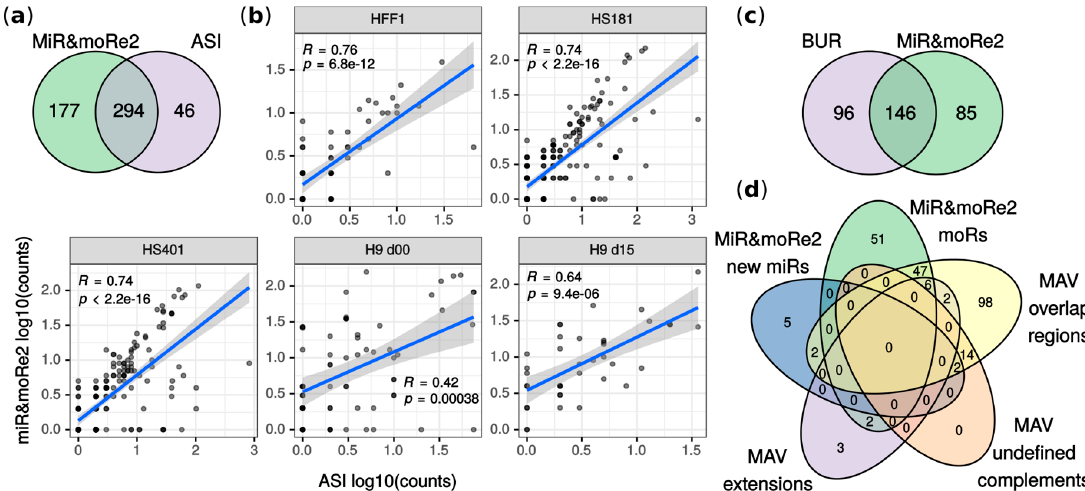
Figure 2. Comparison between original work results and miR&moRe predictions. ( a ) MoRNAs detected by miR&moRe2 from the ASI dataset overlap to moRNAs reported in [14]; ( b ) correlation of moRNA expression estimates (read counts) between miR&moRe2 predictions and values in [14] for each sample of the dataset (human embryonic stem cell lines HS181, HS401 and H9, plus fibroblast HFF-1). H9 d00/d15: day 0 and day 15 of H9 differentiation as detailed in [14]; ( c ) moRNAs reported in [20] compared to miR&moRe2 moRNAs predicted from the BUR dataset; ( d ) miR&moRe2 moRs and new miRs predicted from the MAV dataset, compared to miRNA gene aligned sequences grouped as in [29] (overlap-regions, undefined complement and extension sequences).